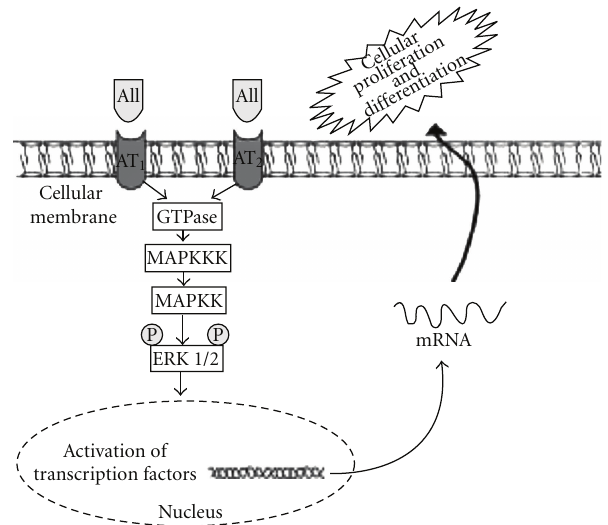
Figure 1: Schematic representation of angiotensin II (AII)-induced extracellular signal-regulated protein kinase (ERK) activation. AII acts through the type 1 AII (AT 1 ) and type 2 AII (AT 2 ) membrane receptors initiating intracellular signaling, with MAPK phosphory- lation and activation of transcription factors in the nucleus, result- ing in mRNA production for mediators of cellular di ff erentiation and proliferation. GTPase: guanosine triphosphatase; MAPKKK: MAPKK kinase; MAPKK: MAPK kinase; ERK: extracellular signal- regulated protein